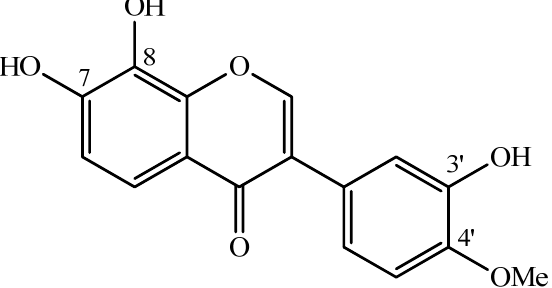
Figure 1. Chemical structure of 7,8,3'-trihydroxy-4'-methoxyisoflavone isolated from D. alata Vogel